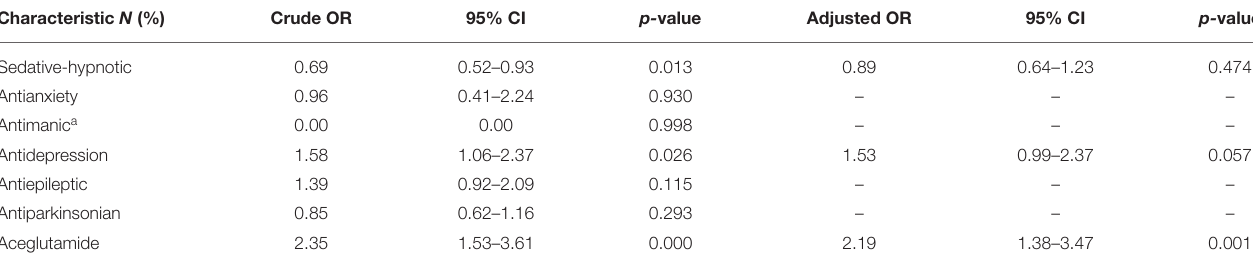
TABLE 3 | Risk analysis of non-antipsychotic drug use and HAP infection. Characteristic N (%) Crude OR 95% CI p- value Adjusted OR 95% CI p-